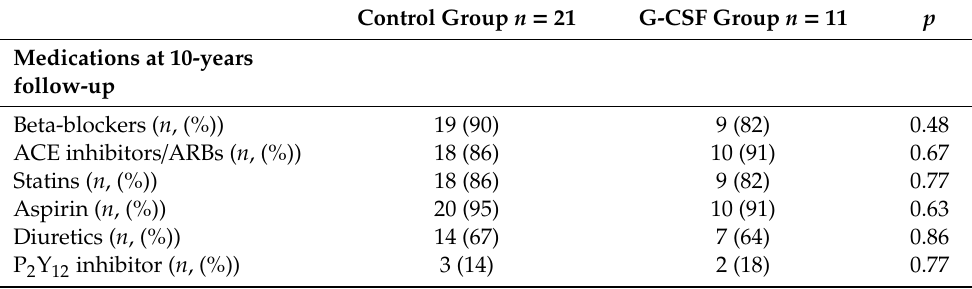
Table 2. Medications at 10-years